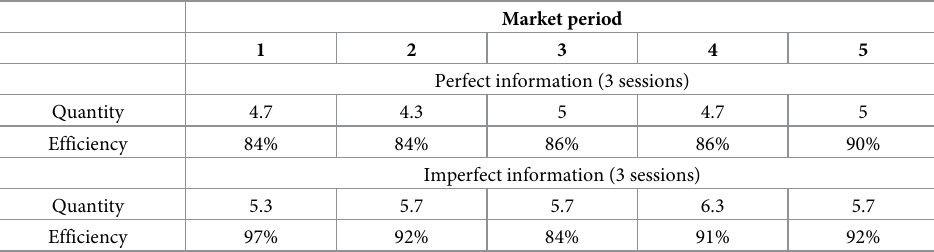
Table 7. Sample statistics from